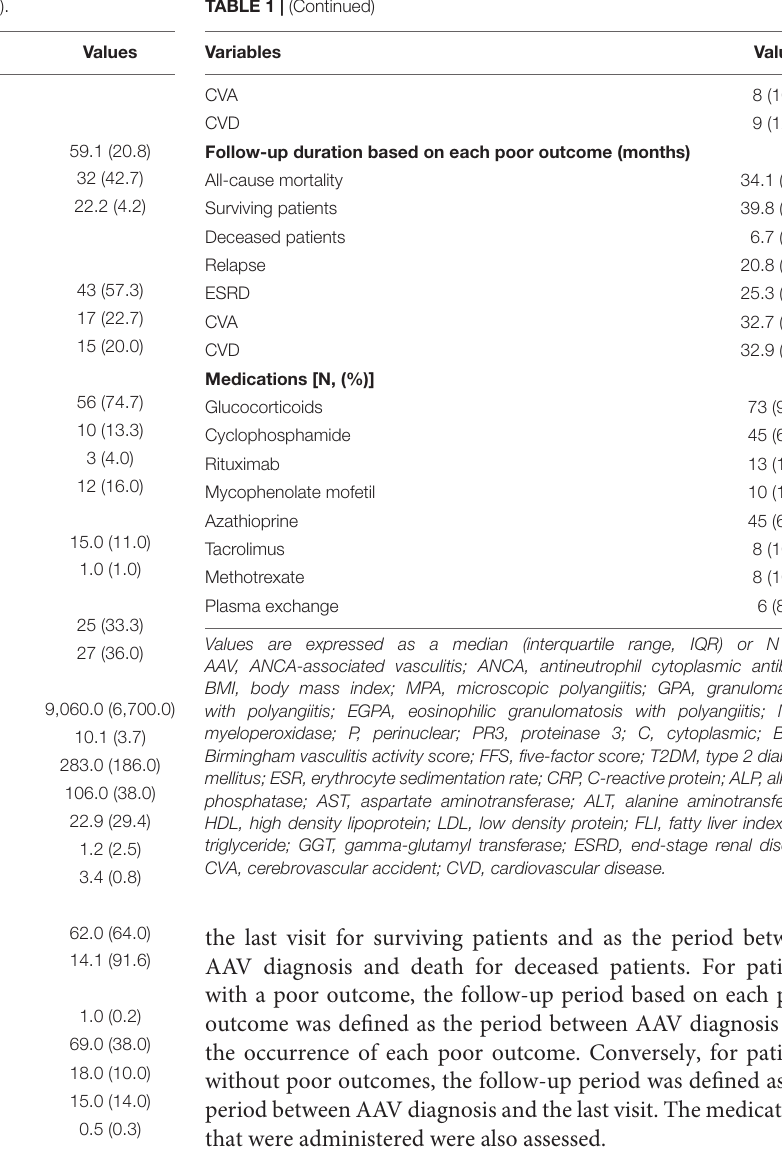
TABLE 1 | Baseline characteristics of AAV patients ( N =